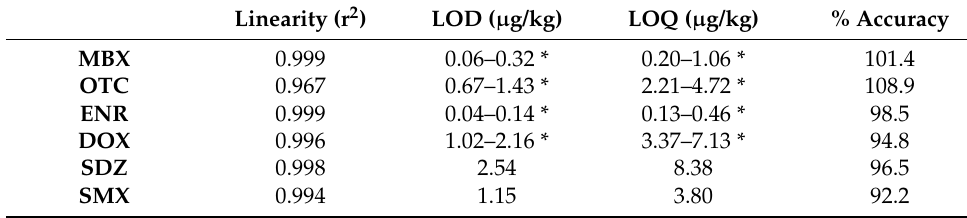
Table 2. Analytical parameters for the applied LC–MS protocol.